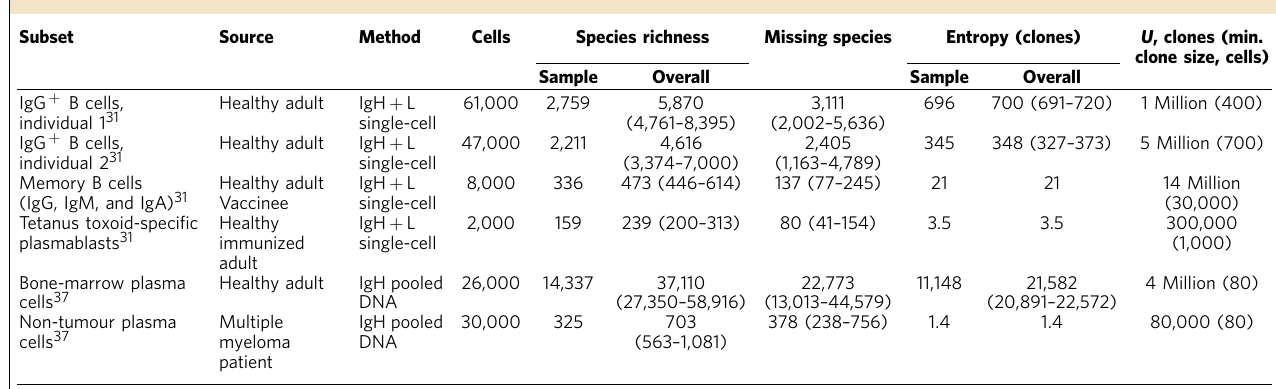
Table 2 | Diversity estimates for experimental data sets from humans. Subset U , clones (min.